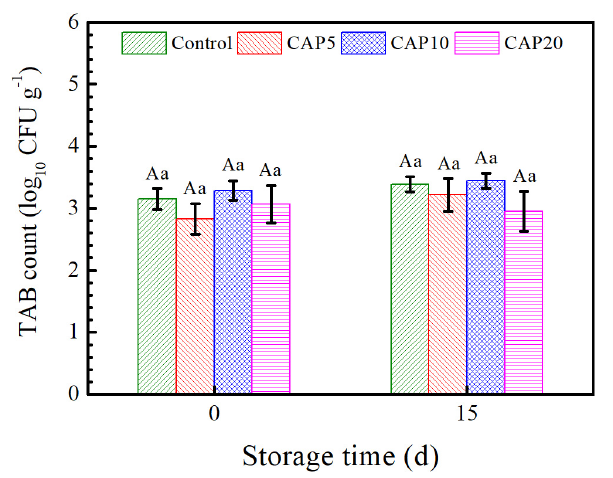
FIGURE 3 | Total native aerobic bacterial (TAB) count of jujubes in CAP5, CAP10, CAP20, and control at days 0 and 15. Small and capital letters show the similar meanings as Figure 2